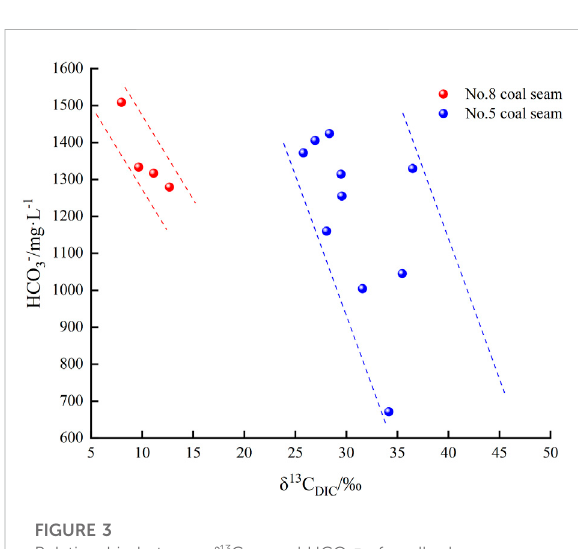
FIGURE 3 Relationship between δ 13 C DIC and HCO 3 − of coalbed- produced water in the Linfen mining area.